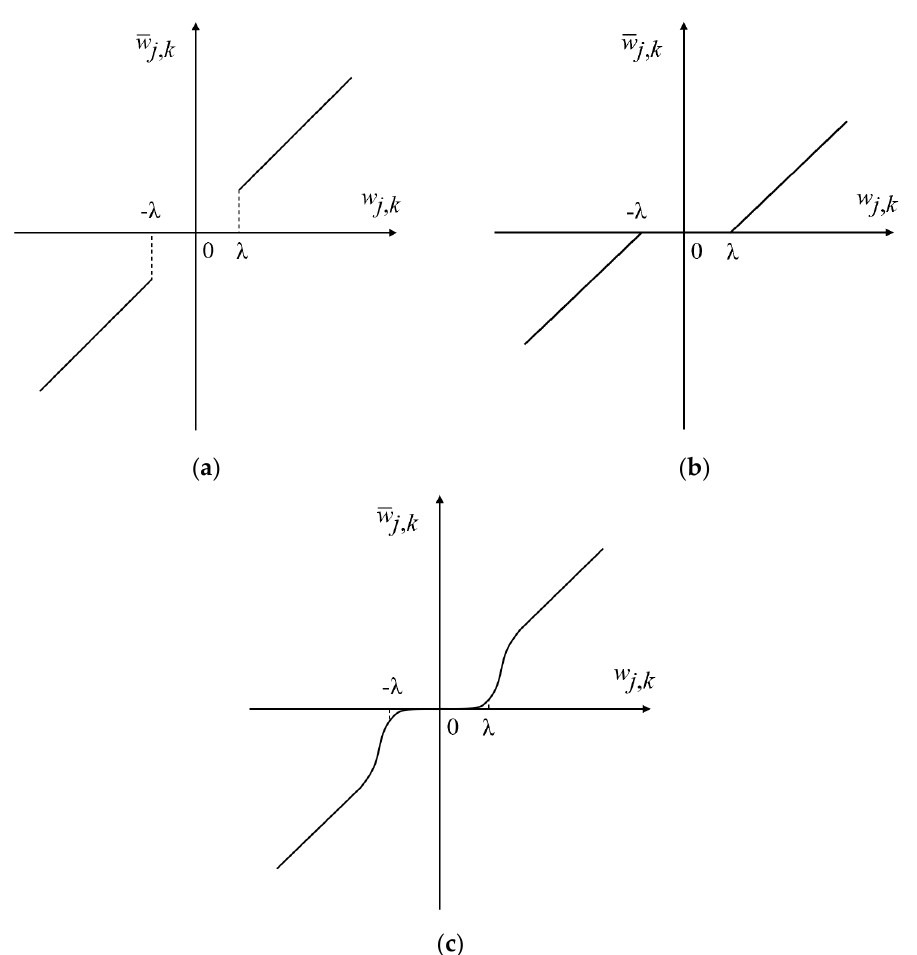
Figure 2. Different threshold function curves: ( a ) hard threshold function; ( b ) soft threshold function; ( c ) improved threshold function.